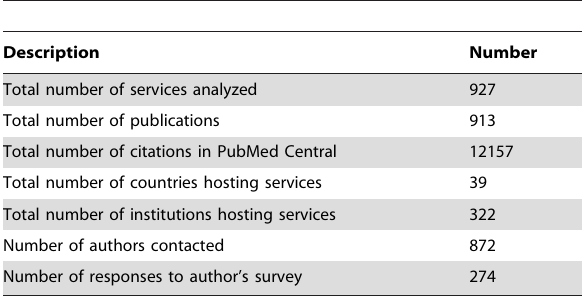
Table 1. Key statistics for this study, across all NAR Web Server Issues from 2003 to